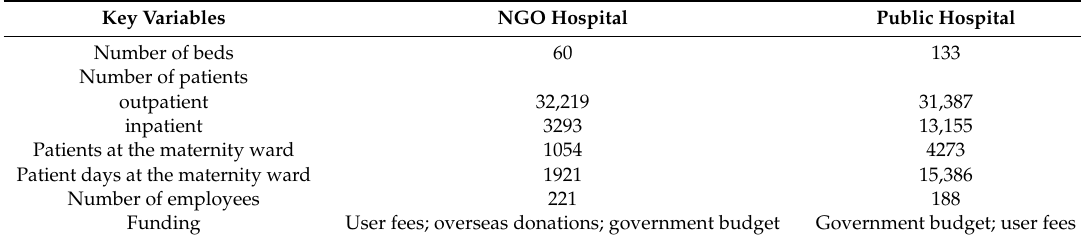
Table 1. Study hospitals (2018